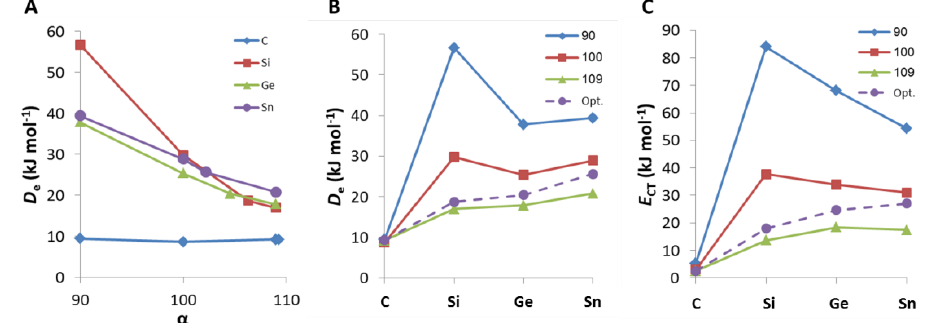
Figure 2. Complexation of 1 T with HCN: ( A ) dissociation energy as a function of the α angle; ( B ) dissociation energy as a function of the tetrel atom; ( C ) NBO n → σ * charge transfer energy as a function of the tetrel atom.